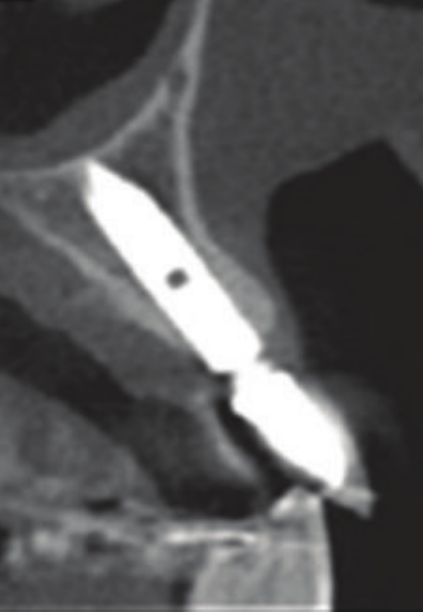
Figure 7: Final computed